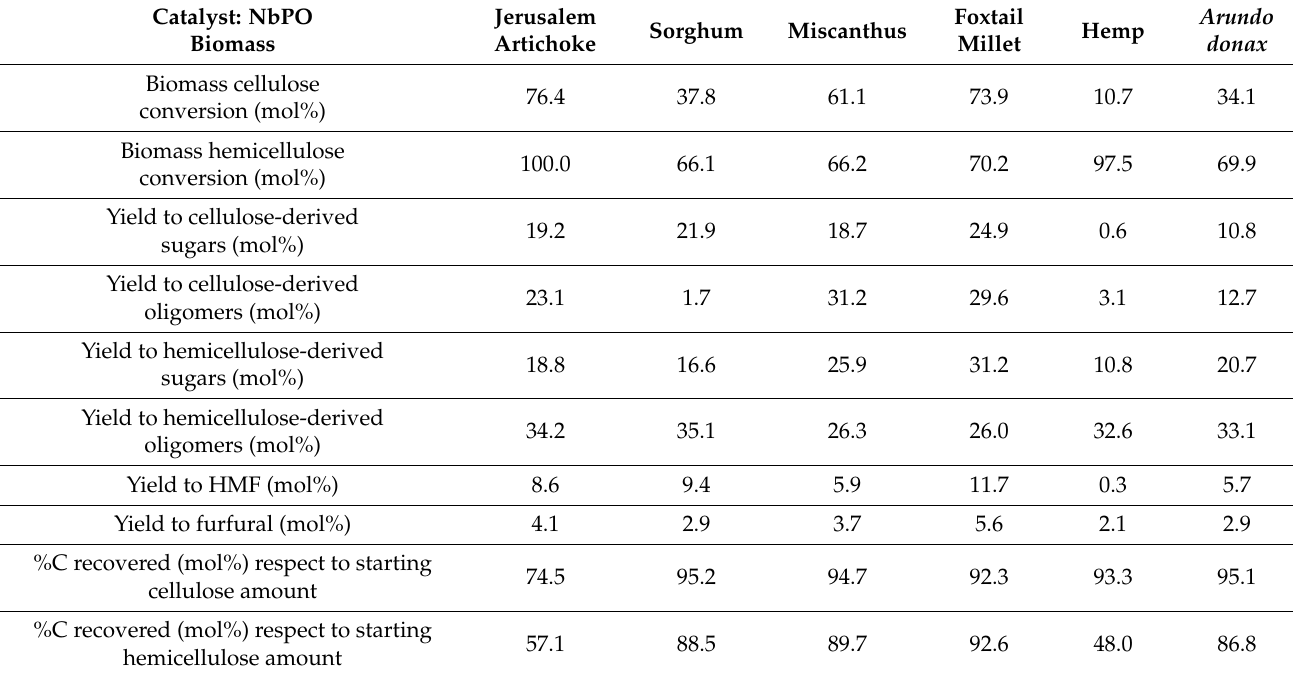
Table 9. Catalytic performances of NbPO in the conversion of lignocellulosic biomasses at 150 ◦ C.